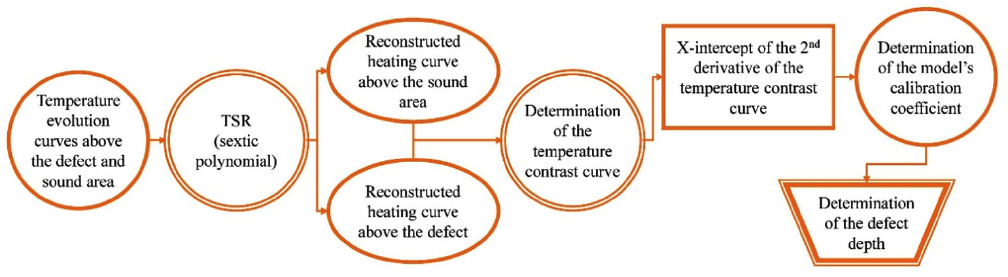
Fig. 16. Block diagram for the process of defect depth